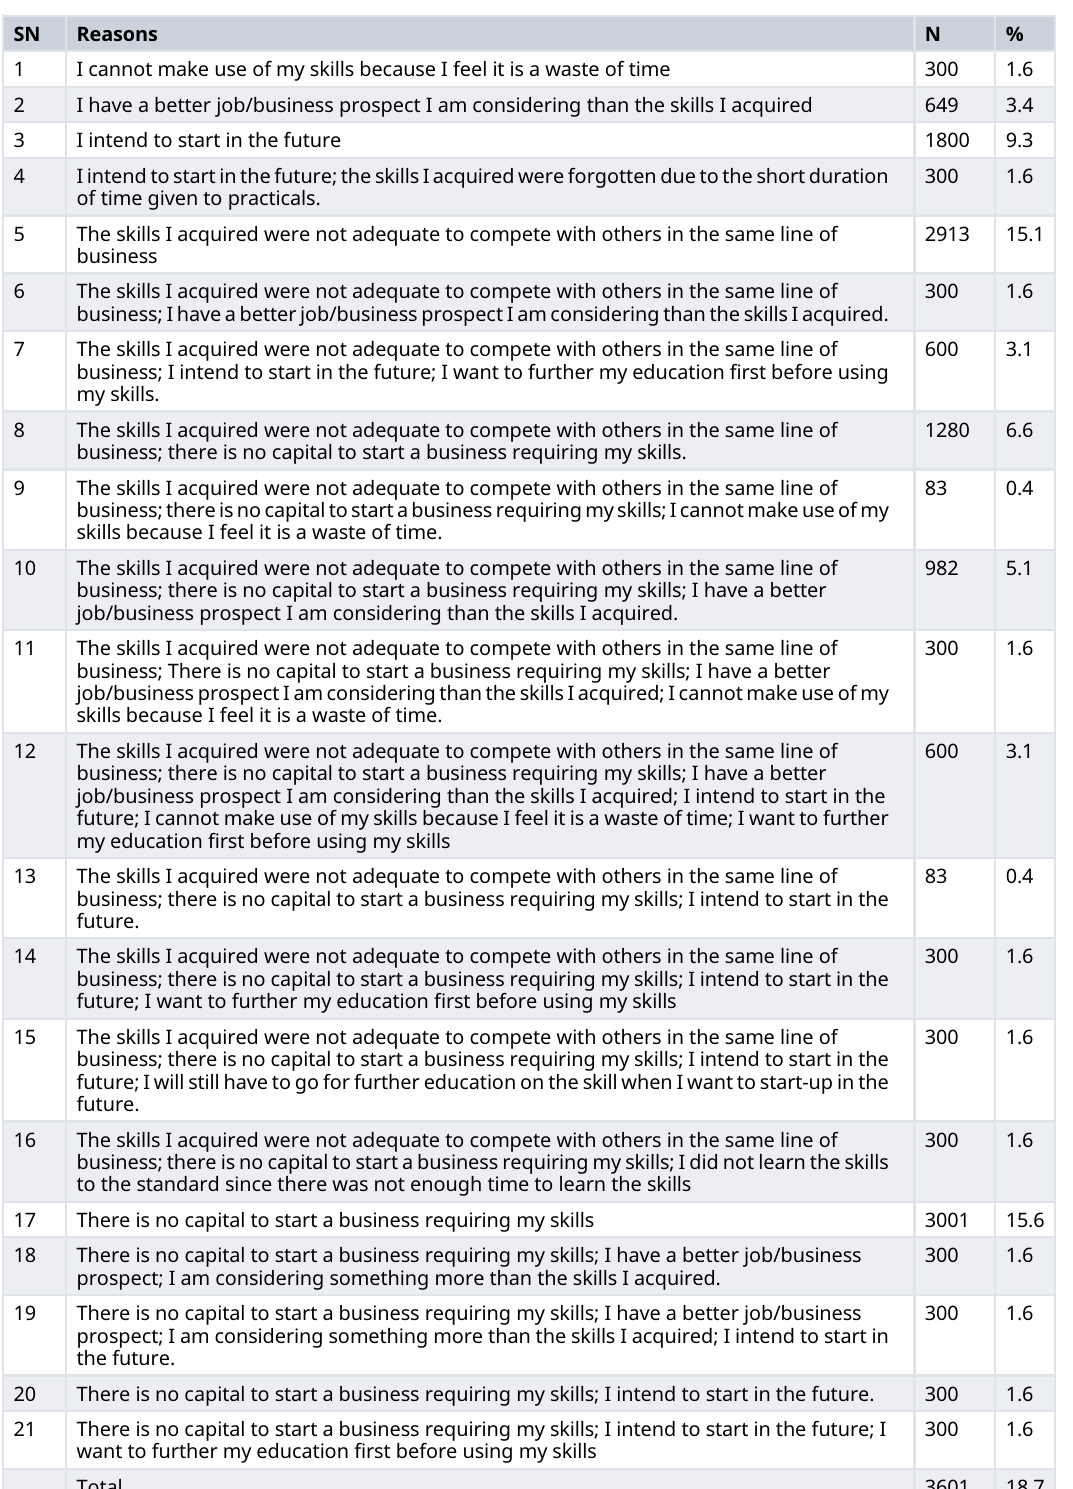
Table 8. Combinations of reasons why corps members are not using the skills acquired from